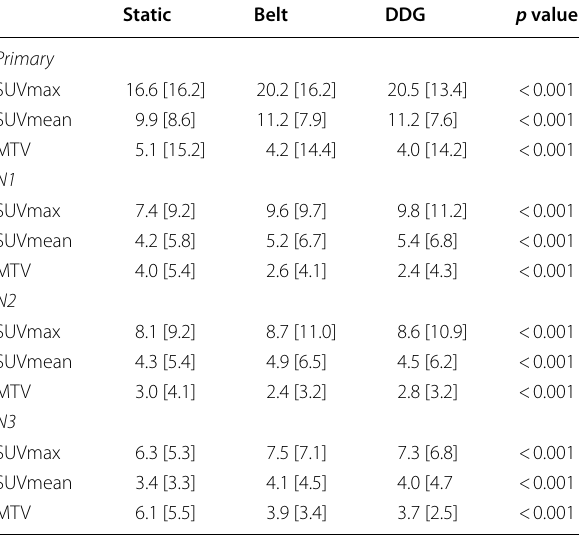
Table 6 Median SUV and MTV for different methods and location, interquartile range in square